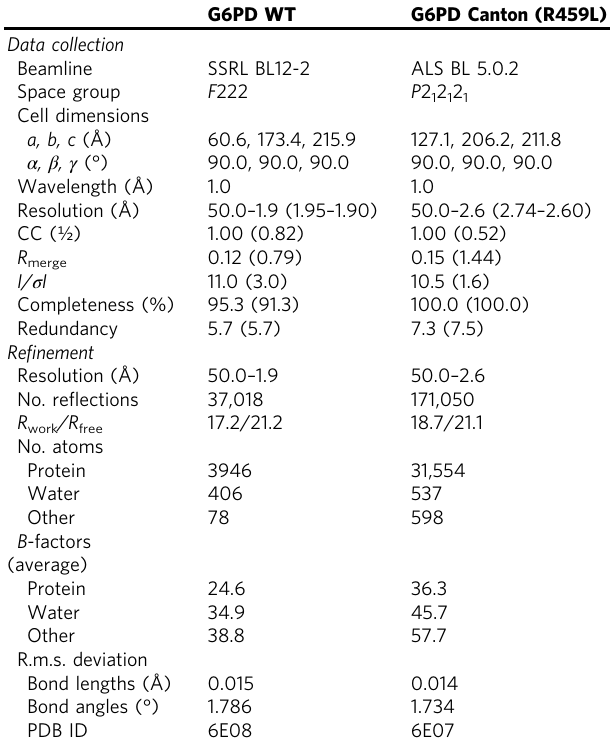
Table 1 Diffraction data and re fi nement